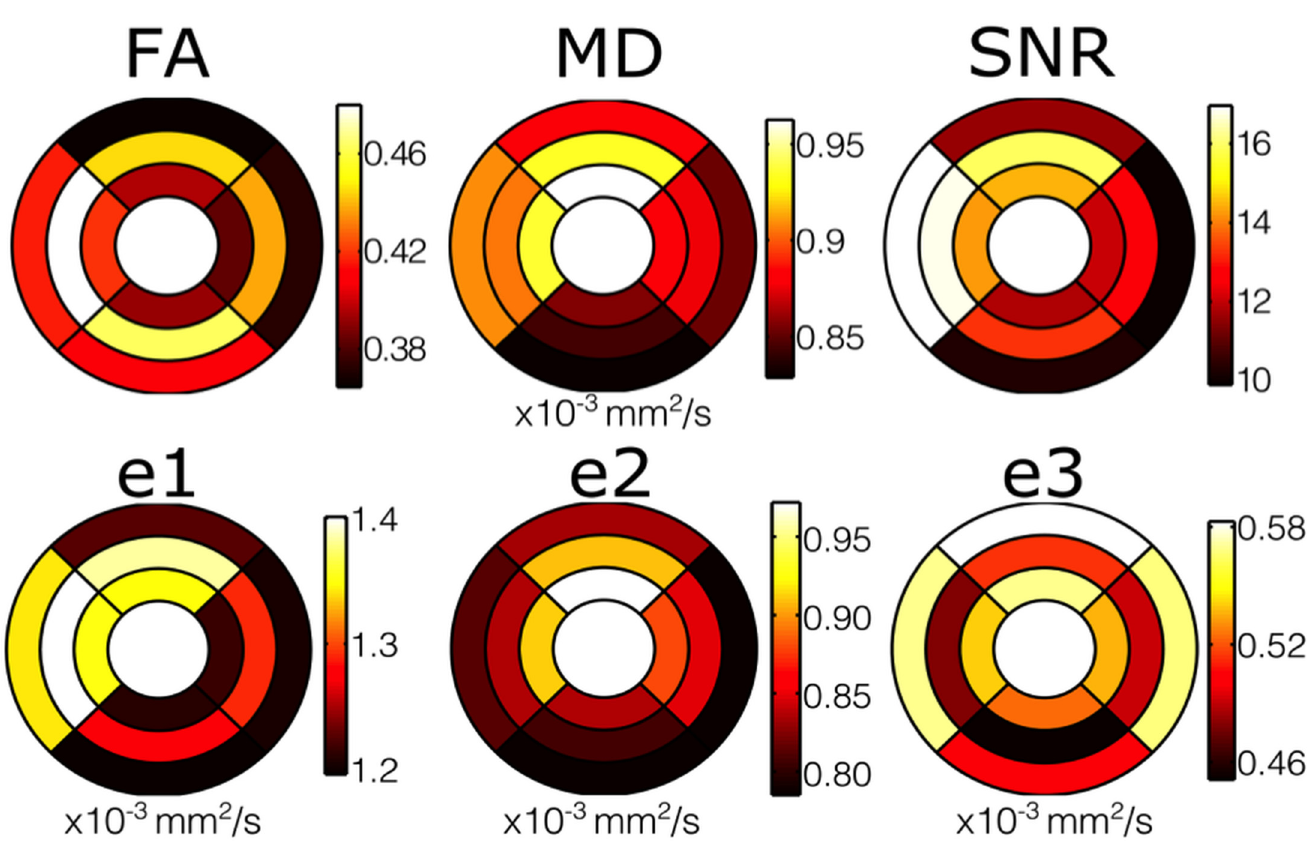
Fig 5. Colour Bullseye maps showing the significant heterogeneity in the distribution of FA, MD, SNR and e1-e3. The outer ring shows results from the epicardium, the middle ring shows the mesocardium, and the inner ring shows the endocardium of the single left ventricular slice. The four walls are also shown in their usual positions: Upper- anterior wall; left- septum; lower- inferior wall; right- lateral wall.